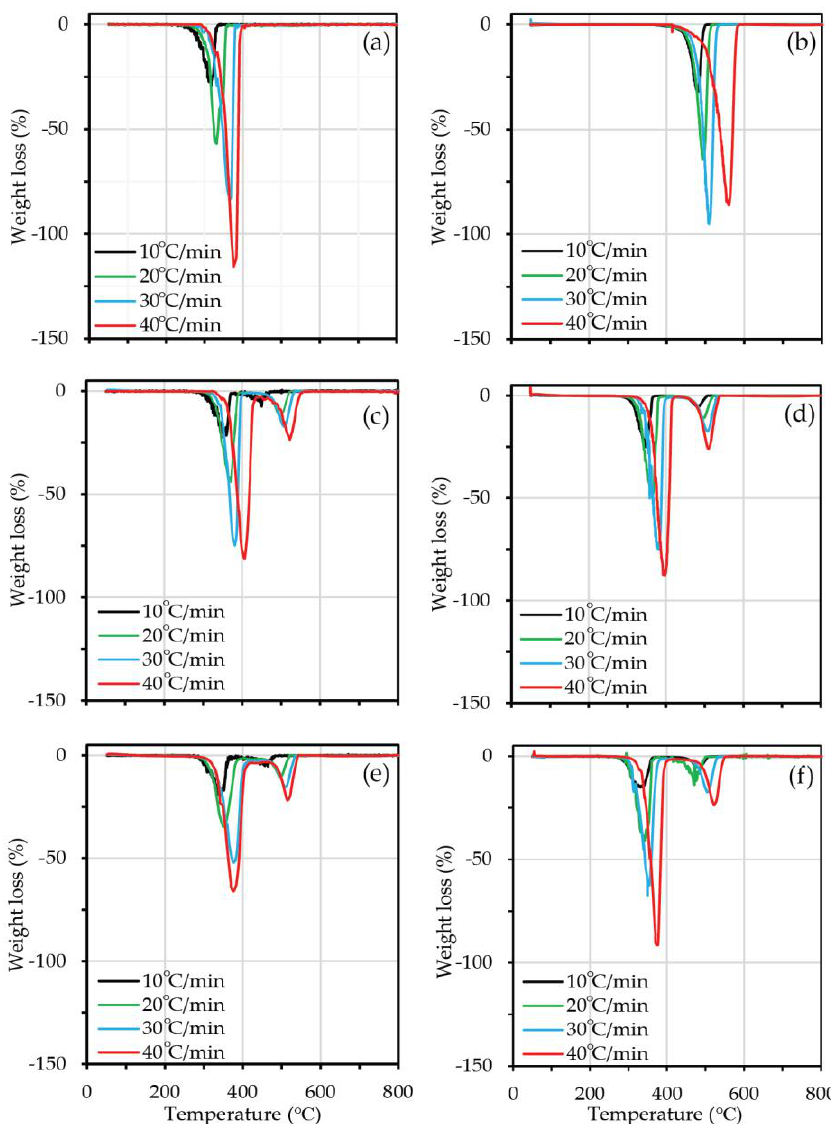
Figure 7. Derivative thermogravimetric analysis (DTG) curves of ( a ) PLA, ( b ) PP, and PLA/PP blends with LNR−g−MMA of ( c ) 0.0, ( d ) 2.5, ( e ) 5.0, and ( f ) 10.0 phr. Table 1. Thermal degradation temperatures of PLA, PP, and PLA/PP (70:30 wt%) without and with compatibilizer.